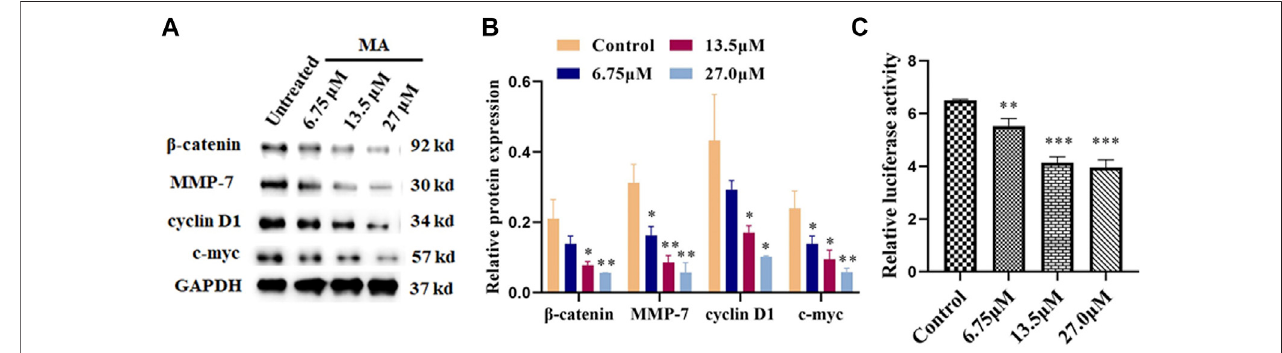
FIGURE 4 | MA inhibits the activation of Wnt/ β -catenin signaling. (A) Western blotting images: MA decreases the protein expression levels of β -catenin, cyclin D1, MMP-7, and c-Myc. GAPDH was used as internal control. (B) Quanti fi cation of associated proteins. (C) MA decreases the luciferase activity of the Top fl ash fi re fl y luciferase. The obtained results were expressed as means ± SD (n (cid:1) 3) (relative to the control group, * p < 0.05, ** p < 0.01, *** p <